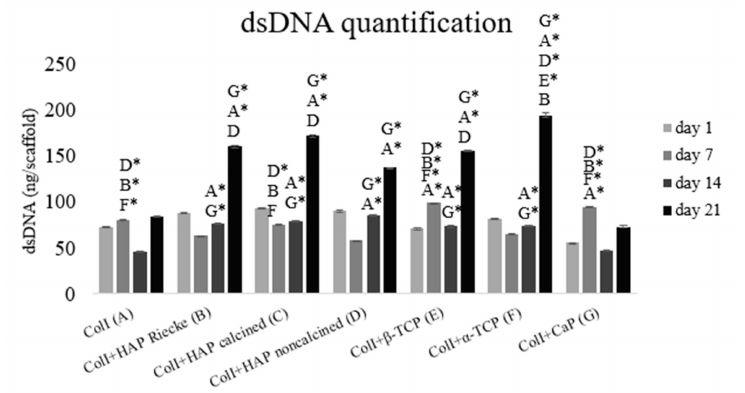
Figure 3. Quantification of cellular dsDNA measured with PicoGreen assay. Cells seeded on: Coll ( A ), ColI+HAP Reicke ( B ), ColI+HAP calcined ( C ), ColI+HAP noncalcined ( D ), ColI+ β -TCP ( E ), ColI+ α - TCP ( F ) and ColI+CapolyP ( G ). Statistical significance marked with the name of group and asterisk sign for p <